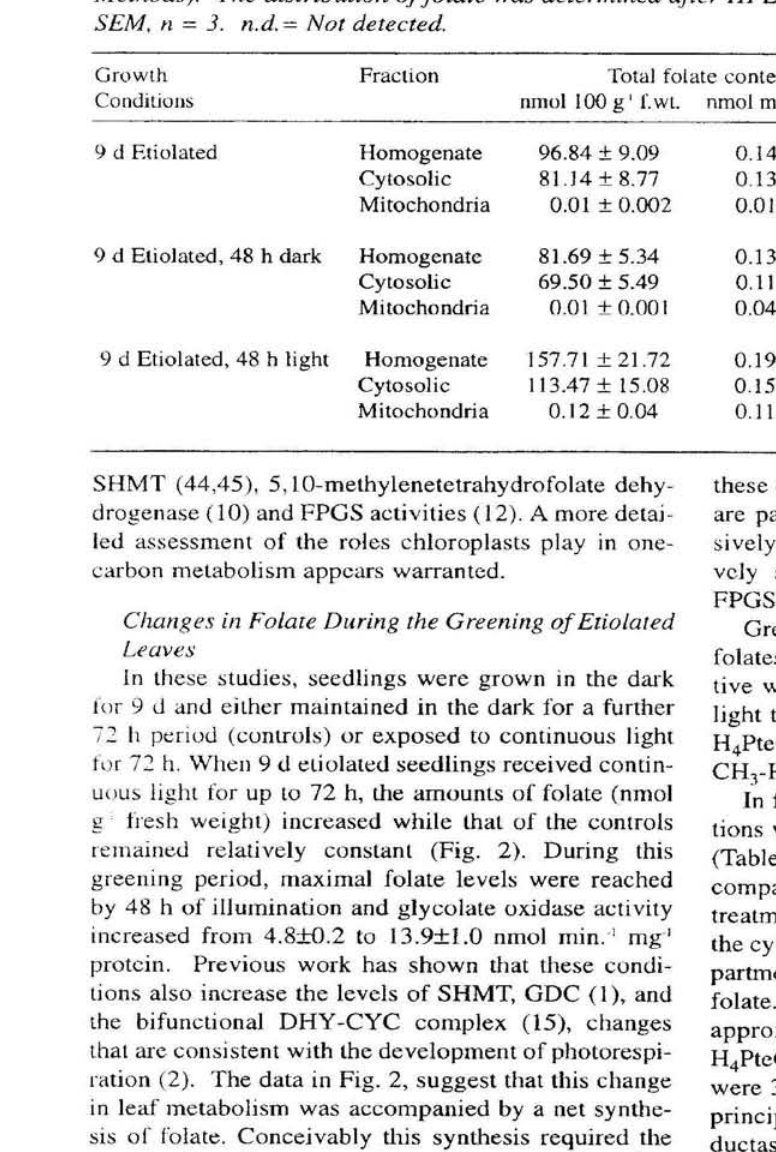
Table 4. Effect of